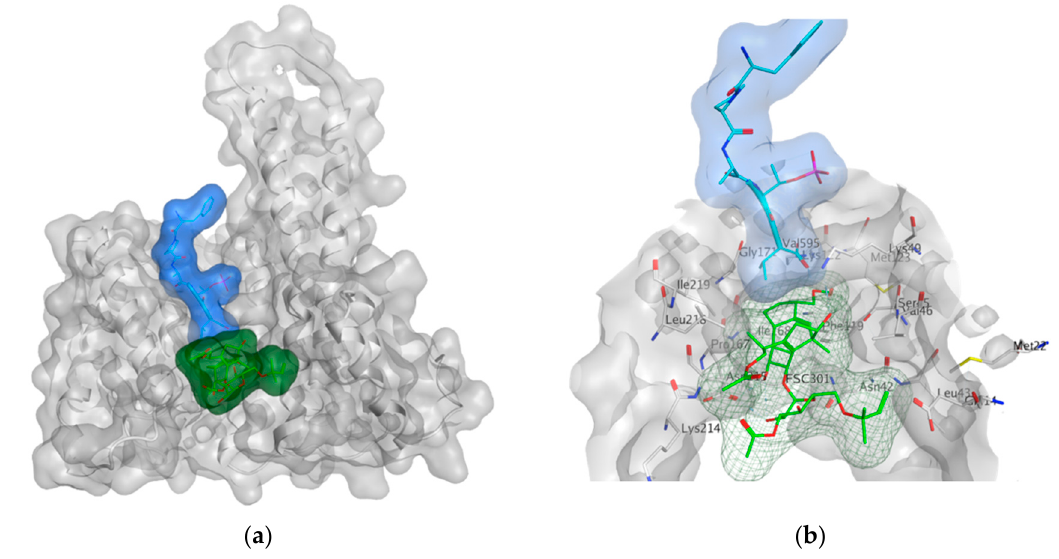
Figure 18. ( a ) Fusicoccin (green) stabilizing ER α (Blue) and 14-3-3 (grey) complex (pdb: 4JDD); and ( b ) site view of fusicoccin (green) interaction with ER α (blue) and 14-3-3 (grey) (pdb: 4JDD).